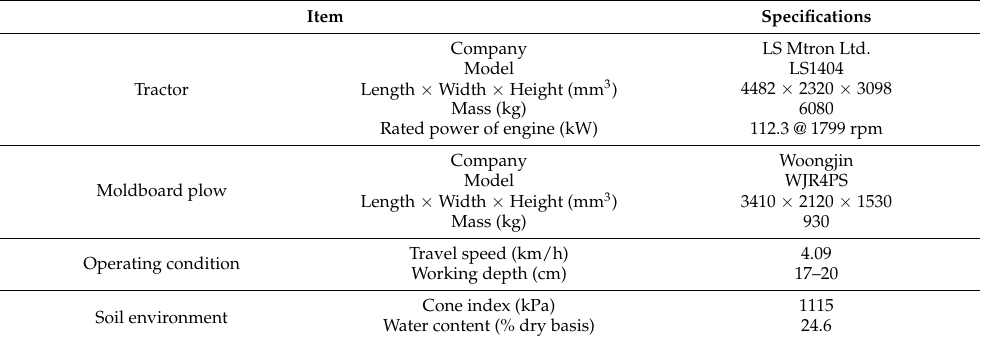
Table 3. Specifications of the conventional tractor, implements, and conditions of field test.